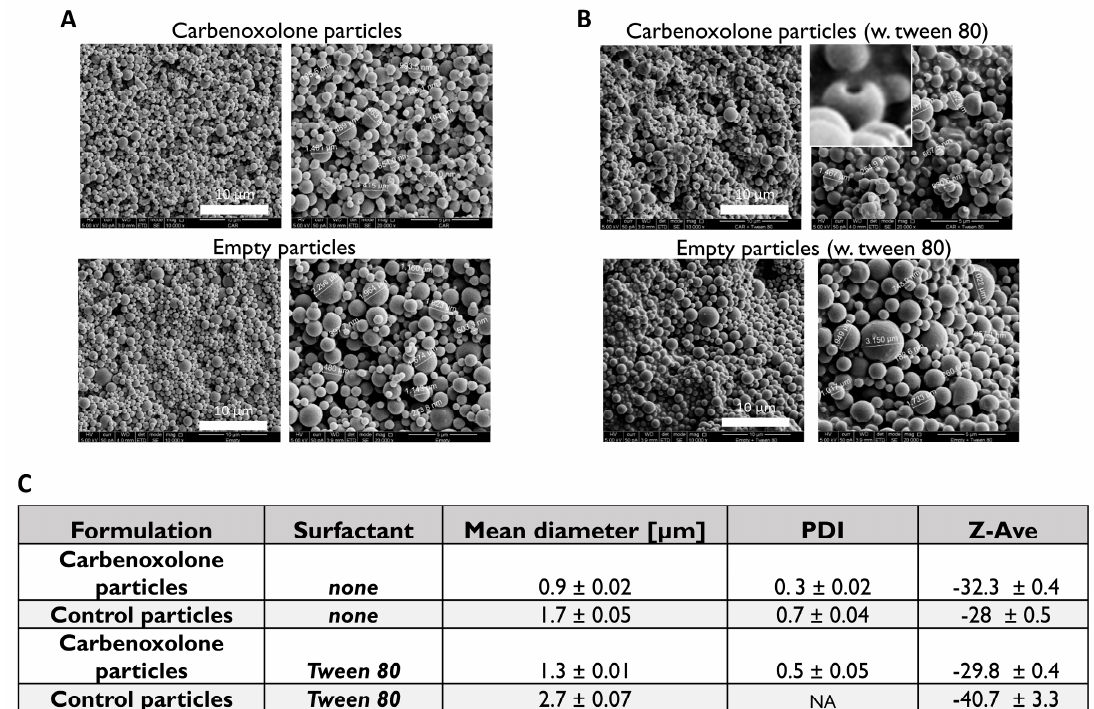
Figure 2. Fabrication of carbenoxolone-loaded particles. Effect of surfactant (Tween 80) on the size of particles. ( A ) Scanning electron microscope (SEM) images of PLGA particles fabricated by double emulsion. Without surfactant, particles are of smooth and spherical shape; ( B ) the effect of the addition of surfactant on the mean diameter and size distribution of particles; and ( C ) a summary of the effect of surfactant on drug encapsulation and the size of particles.